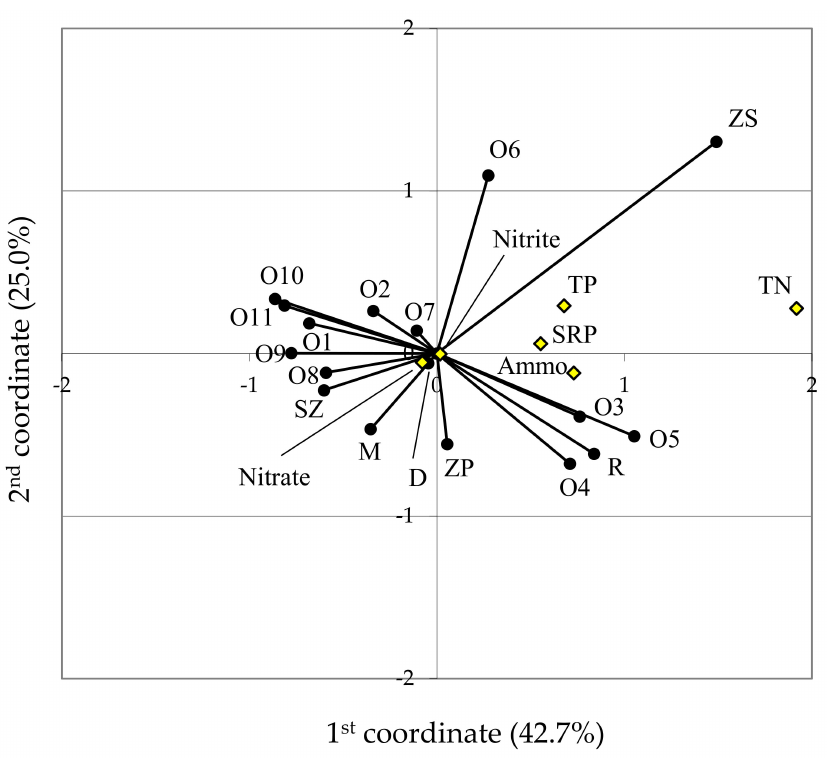
Figure 10. Position of monitoring sites determined by trophic parameters in the space of the first two canonical varieties and spacing of these parameters in the dual space (trait coordinates rescaled and divided by